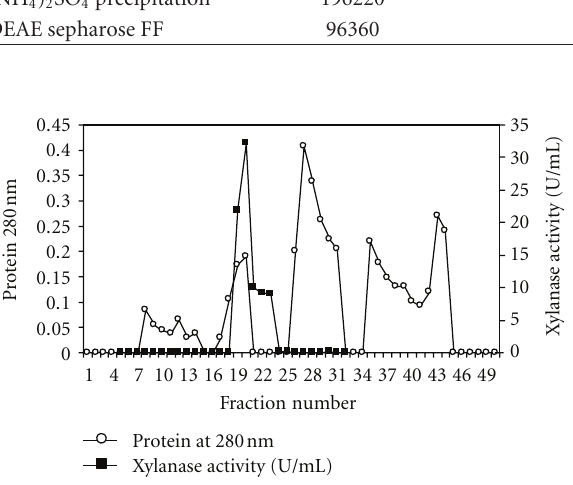
Figure 3: Elution profile of xylanase from DEAE-cellulose column chromatography.